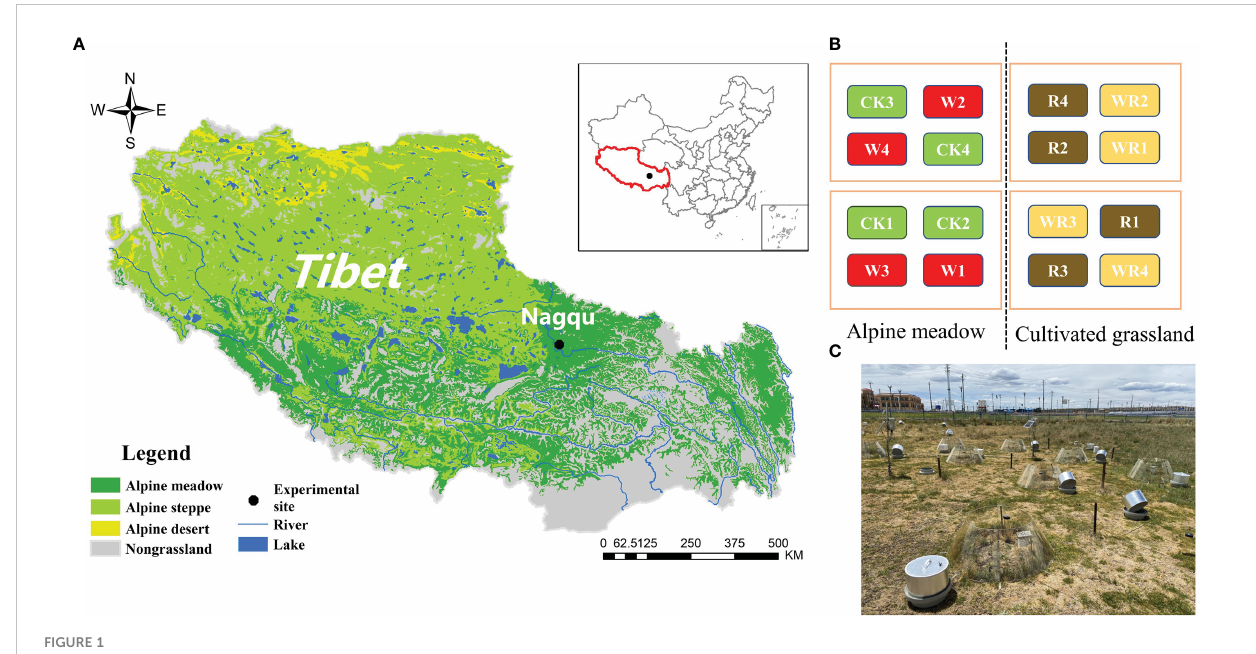
FIGURE 1 The fi gure of experimental site location (A) , plot diagram (B) and realistic scene (C)